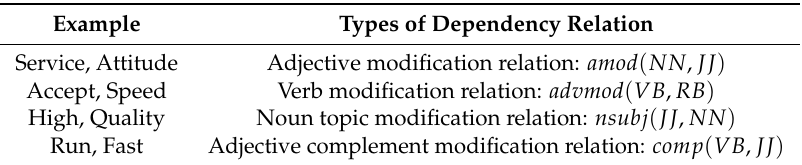
Table 2. An example of Dependency